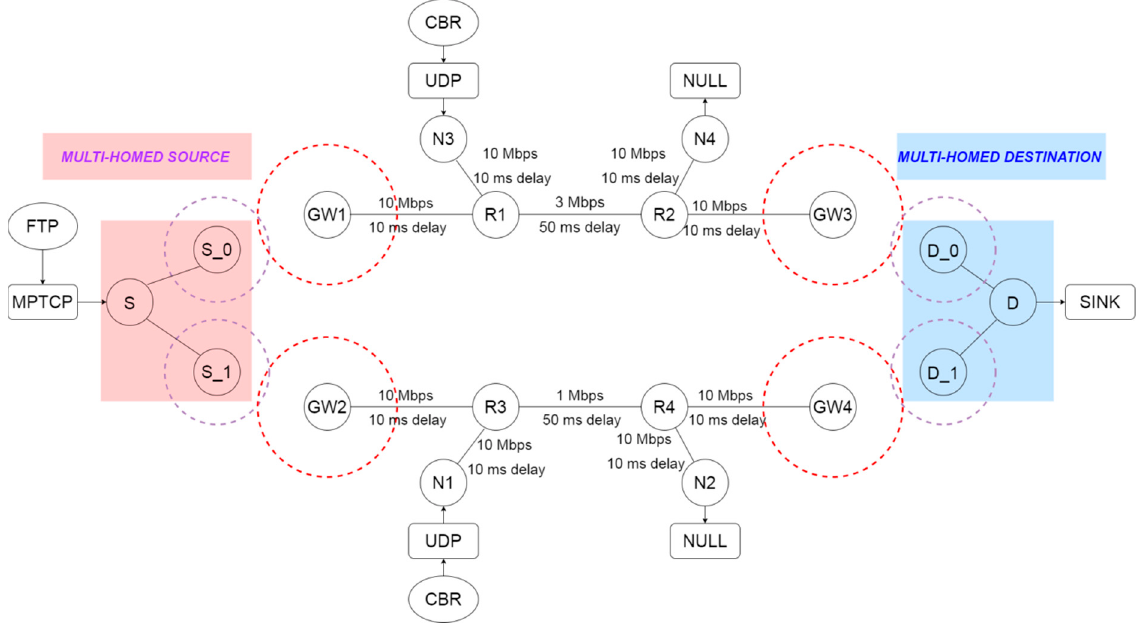
Figure 3. Simulation topology.